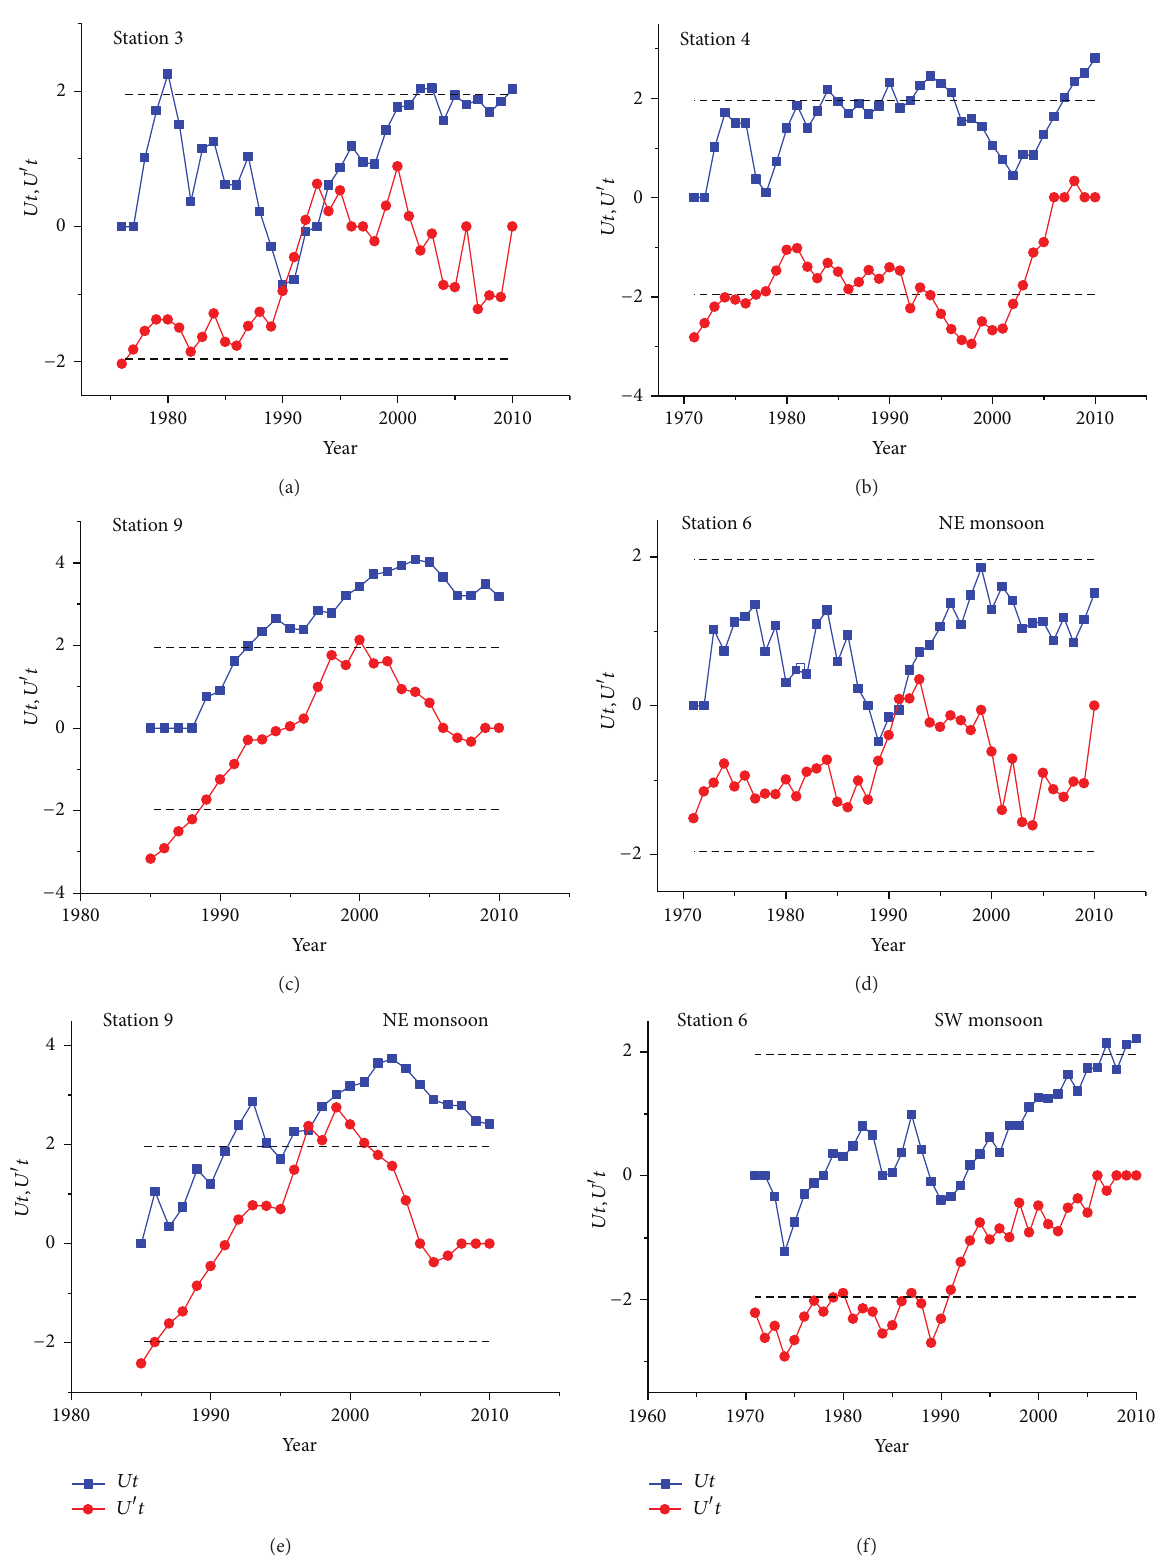
Figure 5: Graphical example of 𝑈(𝑡) and backward series U 󸀠 (𝑡) of the MKRS test for annual analysis ((a), (b), and (c)), NE monsoon season ((d), and (e)), and SW monsoon (f) for precipitation and temperature at the stations with significant trends at the 95% confidence